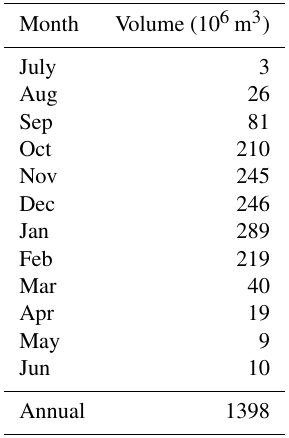
Table 1. Monthly irrigation requirements in the Murrumbidgee basin used in the water allocation model. Values are based on es- timations from Khan et al. (2004,